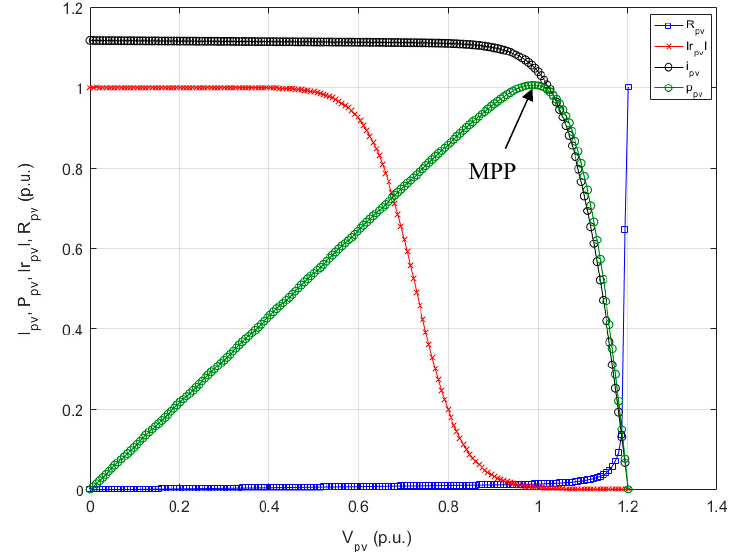
Figure 16. The characteristic per-unit curves of the actual PV panel Suntech power STP175s-24 at irradiance of 600 W/m 2 .